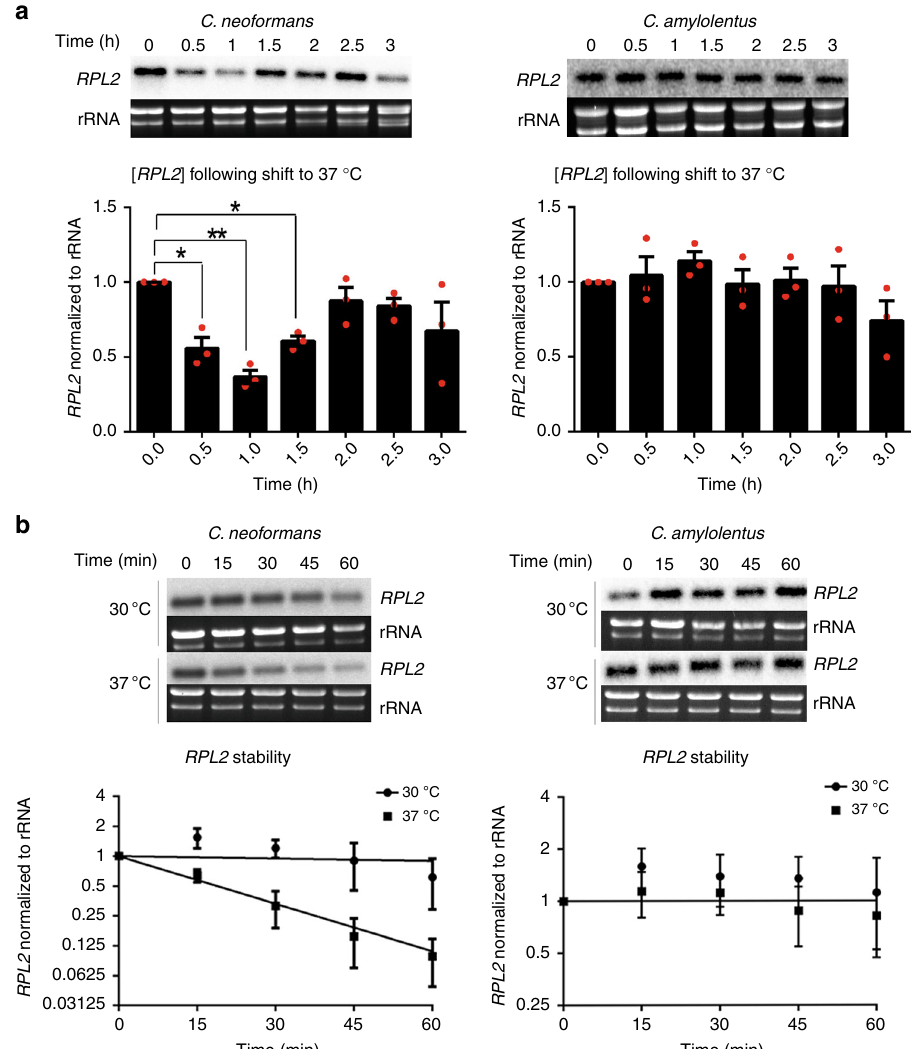
Fig. 1 Enhanced RP transcript decay and repression is absent in C. amylolentus . a Wild-type C. neoformans and C. amylolentus strains were grown to mid-log phase in YPD at 30 °C and then shifted to pre-warmed 37 °C YPD. RNA was extracted from samples every 30 min for 3 h for northern blot assessment of RPL2 levels. Graphs show mean RPL2 levels ± s.e.m. normalized to rRNA, n = 3. Expression of RPL2 at each time point was compared with t = 0 for each strain by ANOVA with Dunnett ’ s test post hoc. b Stability of RPL2 at 30 °C and following a shift to host temperature was assessed by northern blot analyses in wild-type C. neoformans and C. amylolentus . Transcription was inhibited by the addition of 1,10-phenanthroline, and RNA was extracted from samples collected every 15 min for 60 min. Graphs show the log2 regression of RPL2 normalized to rRNA at 30 °C and 37 °C, n = 3. Signi fi cance between curves was detected by sum-of-squares F test, with p < 0.05 determining signi fi cant difference between regression lines. Source data are provided as